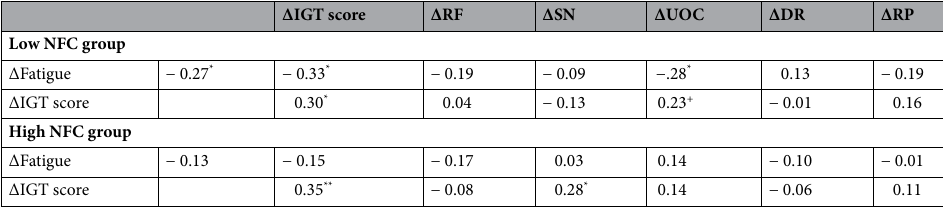
Table 4. Correlation analysis of the changes in fatigue, IGT scores, and A-DMC in Low and High NFC groups. IGT Iowa Gambling Task, RF resistance to framing, SC resistance to sunk costs, RP consistency in risk perception, SN recognizing social norms, DR applying decision rules, UOC under/overconfidence. *p < 0.05; + p <